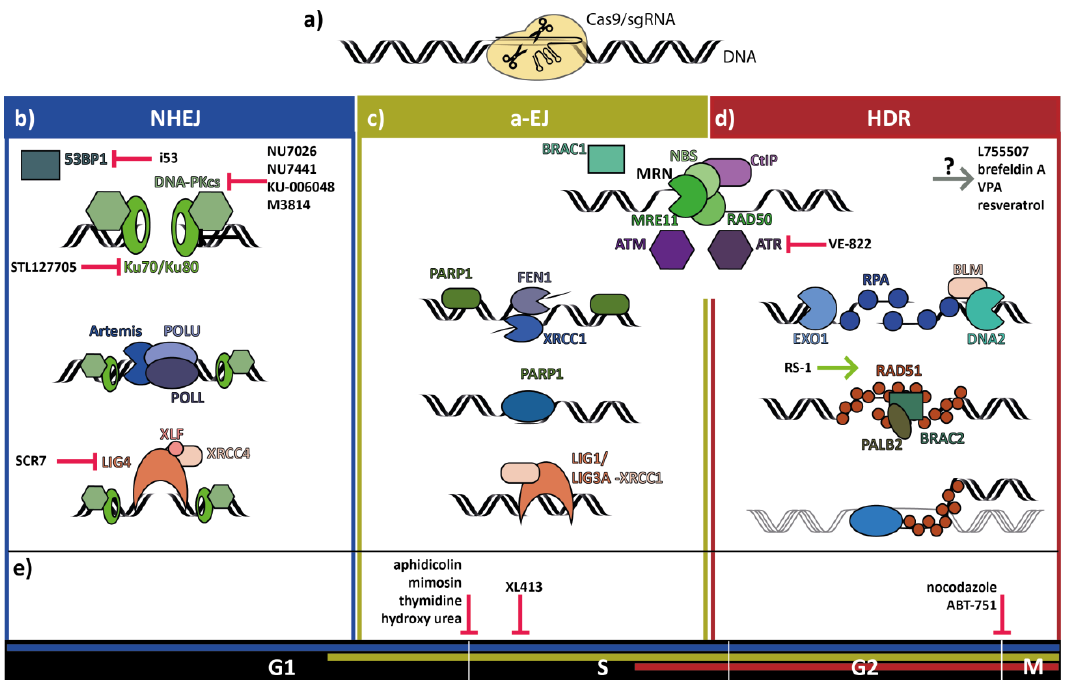
Figure 1. Major mammalian DNA damage repair pathways at Cas9-induced DSBs together with small molecules and one peptide (i53) reported to increase knock-in efficiencies. Shown are the three major repair pathways after a CRISPR/Cas9-induced DNA double-strand break. ( a ) Depicted is a Cas9/sgRNA complex cleaving DNA. ( b ) During Non-Homologous End-Joining (NHEJ) Ku70/Ku80 protect free DNA-ends from end resection. DNA-Protein-Kinase catalytical subunit (DNA-PKcs) phosphorylates different DNA repair enzymes. Ends are processed through Artemis, Polymerase Mu (POLM) and Polymerase Lambda (POLL) and ligated by the Ligase IV, X-Ray Repair Cross- Complementing Protein and 4 XRCC4-like Factor (LIG4-XRCC4-XLF) complex. ( c , d ) Breast Cancer Type 1 (BRCA1) antagonizes p53-Binding Protein 1 (53BP1) and enables end resection mediated by CtBP-interacting protein (CtIP) and the MRN complex Meiotic Recombination 11 (MRE11), RAD50, and Nijmegen Breakage Syndrome 1 (NBS1) necessary for alternative End-Joining (a-EJ) and Homology Directed Repair (HDR). The Kinases Ataxia Telangiectasia Mutated (ATM) and ATM- Rad3- related (ATR) function as damage sensors and activate different repair enzymes. ( c ) In a-EJ extensive end resection is prevented through Poly [ADP-ribose] Polymerase 1 (PARP1). After annealing of short homologies, X-Ray Repair Cross Complementing 1 (XRCC1) or Flap Endonuclease 1 (FEN1) cleave 5′-flaps and Polymerase Theta (POLQ) performs gap-fillings. Ligase I (LIG1) or Ligase III alpha-XRCC1 (LIGA-XRCC1) ligate DNA ends. (d) HDR requires extensive end resection mediated by Exonuclease 1 (EXO1) or Bloom Helicase and DNA2 Helicase/Nuclease (BLM-DNA2). Replication Protein A (RPA) binding of single-stranded DNA prevents the formation of secondary structures. RPA is replaced by RAD51 with the help of Breast Cancer type 2 (BRCA2) and Partner and Localizer of BRCA2 (BRAC2-PALB2). RAD51 promotes homology donor search and base pairing. ( e ) Cell cycle dependency of DNA repair pathways: NHEJ is active through all cell cycle phases. Pathways requiring end resection are mainly active in the S-G2 phase. 2. Non-Homologous End-Joining Repair of Double-Strand Breaks NHEJ is the predominant pathway to repair DSBs in mammalian cells. Broken ends can be repaired using various forms of end processing. In the initial recognition step, Ku70 and Ku80 bind sequence independently to lose DNA ends and form the Ku heterodimer. The complex forms a ring- shape, which keeps the free DNA ends in proximity of each other [6] and prevents end resection. The Ku complex recruits the DNA-Protein Kinase catalytical subunit (DNA-PKcs), which belongs to the